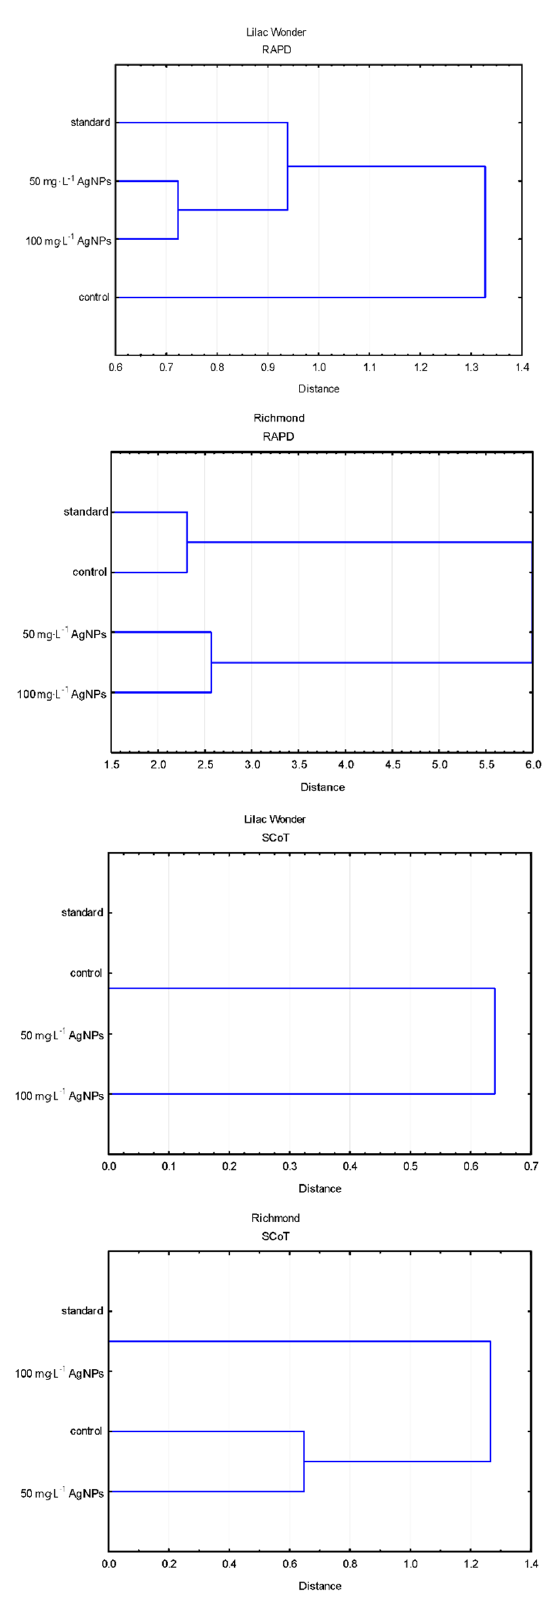
Figure 7. Dendrograms based on the estimation of genetic distance coefficient and UPGMA clustering present in the relationships between the populations of AgNPs-treated, control, and standard plants, revealed by the randomly amplified polymorphic DNA (RAPD) and start codon targeted polymorphism (SCoT) analyses.